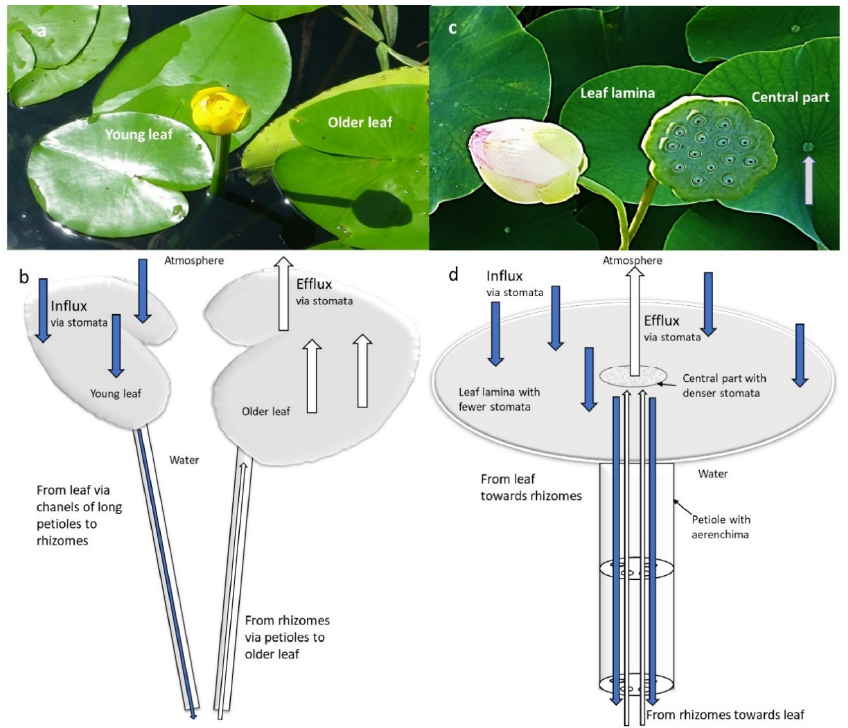
Figure 4. Ventilation system in Nuphar luteum ( a , b ) Nelumbo nucifera ( b , c ). ( a ) N. luteum young and older leaves; ( b ) the scheme of ventilation system where arrows shows that air from atmosphere enters via young leaves through stems with aerenchyma to rhizomes, and via older leaves back to the atmosphere; ( c ) N. nucifera leaves with visible central part with denser stomata; ( d ) the scheme of ventilation system with arrows indicating the direction of flow (blue—influx from atmosphere via stomata in leaf lamina through aerenchyma in leaf and petiole to aerenchyma in rhizomes; light grey—efflux from rhizomes through aerenchyma in petiole to the central part of the lamina, and finally to atmosphere). Photos and drawings: Alenka Gaberš č ik. Polygonum amphibium L. is an amphibious plant with natant leaves. and thrives in water up to 2 m, with its hollow stems that enable the aeration of underground organs (Figure 5). However, gases trapped in the aerenchyma may also benefit the photosynthesis and lower photorespiration rate [57], due to changes in the ratio of internal CO 2 /O 2 concentrations. Figure 5. Polygonum amphibium L. f. natans; ( a ) natant leaves and ( b ) section of a hollow stem. Photo: Matej Holcar.